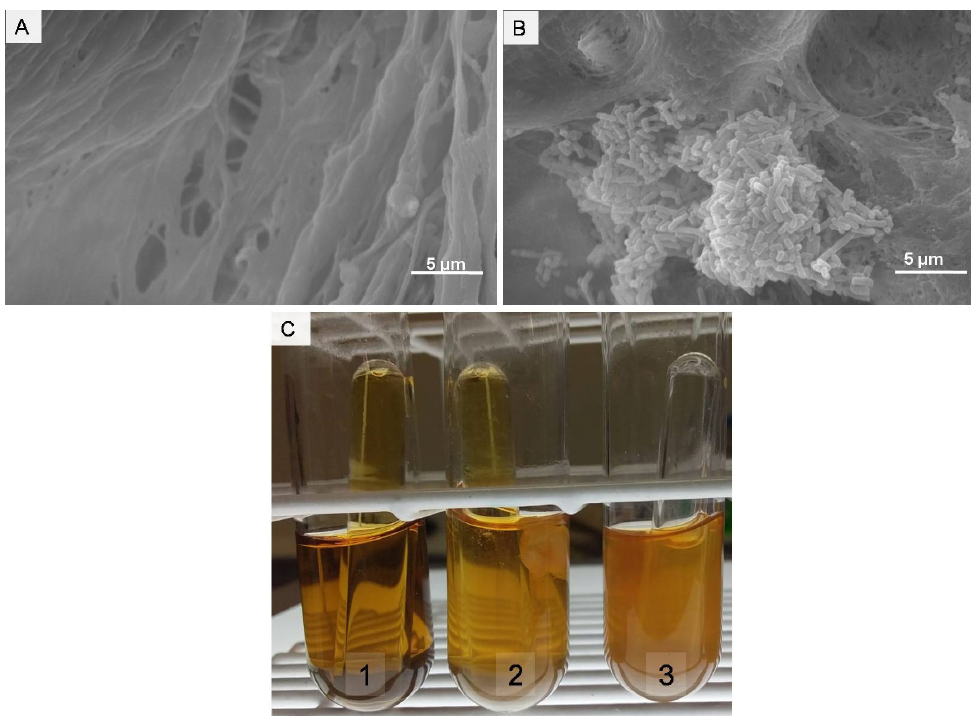
Figure 8. Microbial proliferation in PVA matrices and cell activity in lactose broth. The images shows foam with absence (a) and presence of bacteria E.coli (b) and (c) Durham tube assay: tube 1 – blank; tube 2- foam alone; tube 3- foam +